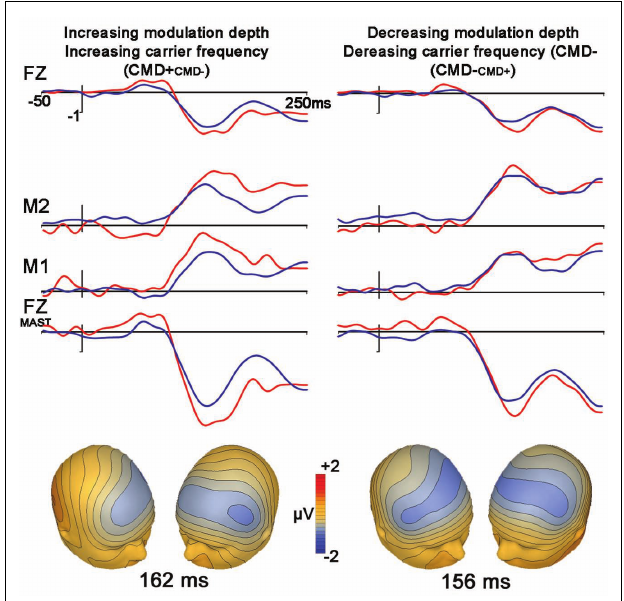
FIGURE 2 | Stimuli extracted from Happy (left) and No-expression (right) prosodic stimuli. Top panel represents grand average waveforms at electrodes FZ, right (M1) and left (M2) mastoid for both standard (blue) and deviant (red) waveforms for FM tones Bottom row represents grand average waveforms that were re-referenced to average mastoids for statistical comparisons of net amplitude differences between conditions. Bottom panel represents voltage topographies of subtraction waveforms (Note: isotemporal lines extending beyond electrode placement areas is an artifact of topography generation